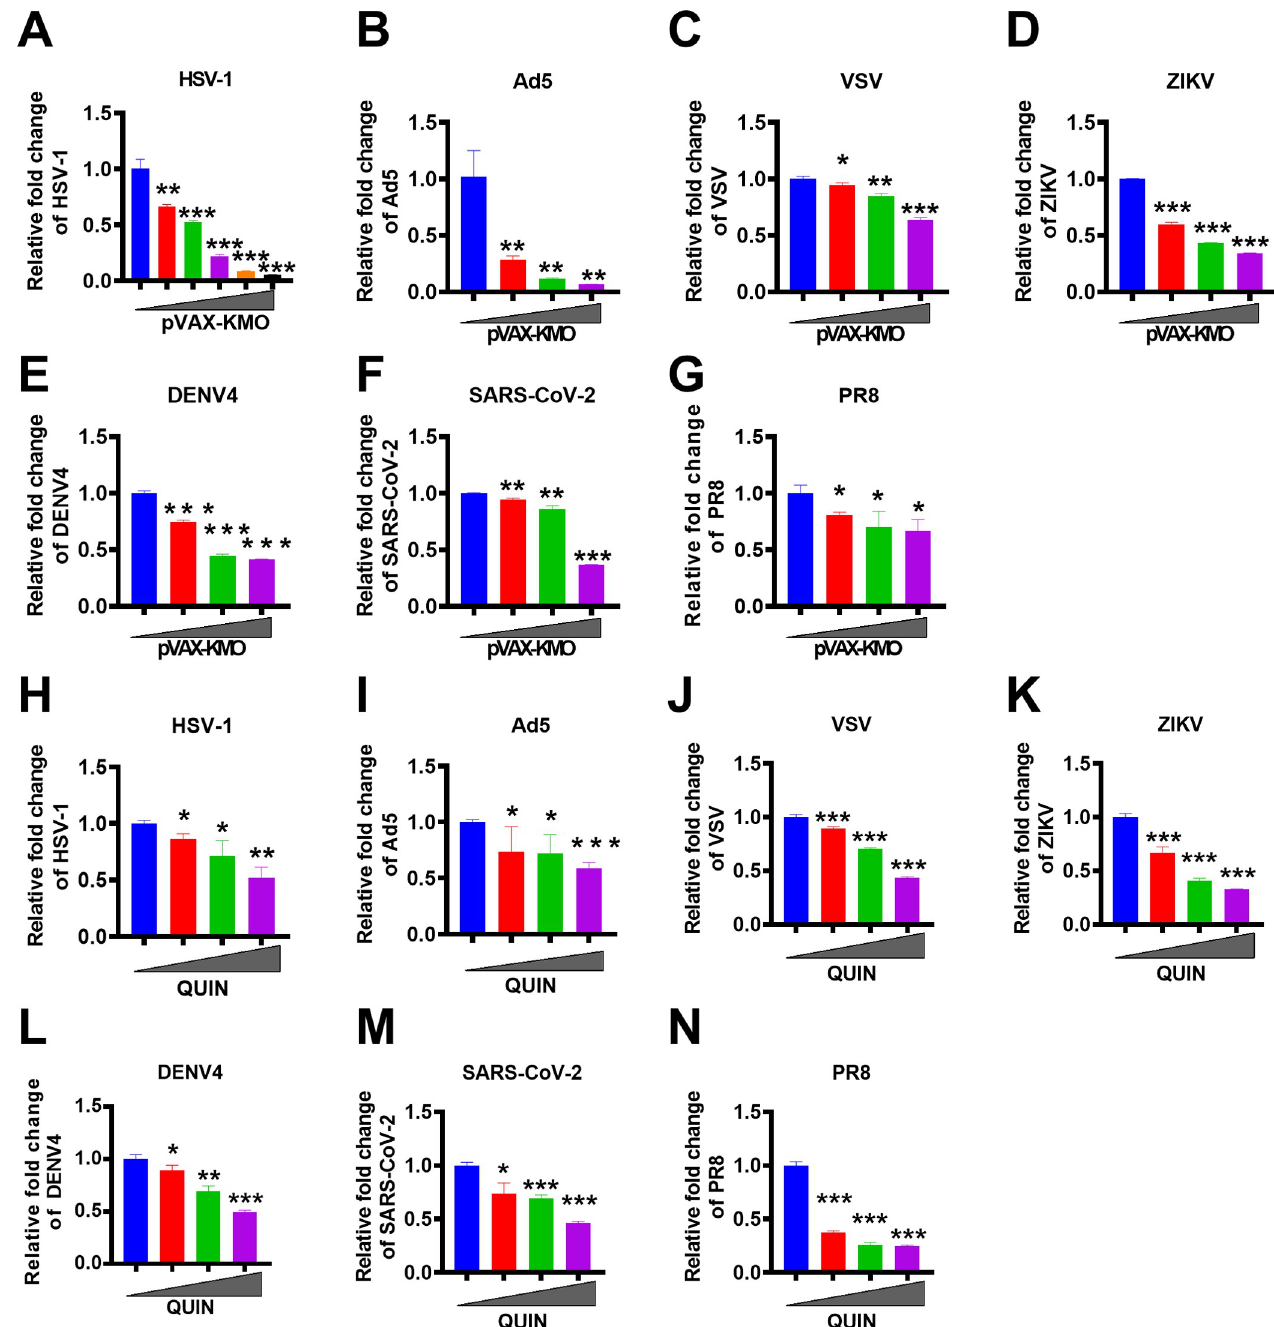
Fig 4. Broadly antiviral activities of KMO and QUIN. (A) 293T cells were transfected with different concentrations of KMO-expressing plasmid for 24 h, followed by HSV-1 infection at MOI of 1 for 8 h. The expression level of HSV-1 UL27 was quantified by RT-qPCR. (B) 293T cells were transfected with different concentrations of KMO-expressing plasmid for 24 h, followed by Ad5 infection at MOI of 1 for 8 h. The expression level of Ad5 was quantified by RT- qPCR. (C) 293T cells were transfected with different concentrations of KMO-expressing plasmid for 24 h, followed by VSV infection at MOI of 1 for 8 h. The expression level of VSV was quantified by RT-qPCR. (D) 293T cells were transfected with different concentrations of KMO-expressing plasmid for 24 h, followed by ZIKV infection at MOI of 1 for 8 h. The expression level of ZIKV was quantified by RT-qPCR. (E) 293T cells were transfected with different concentrations of KMO-expressing plasmid for 24 h, followed by DENV4 infection at MOI of 1 for 8 h. The expression level of DENV4 was quantified by RT- qPCR. (F) CoCa-N-2 cells were transfected with different concentrations of KMO-expressing plasmid for 24 h, followed by replication-competent SARS-CoV- 2 virus-like-particles (SARS-CoV-2 GFP/ Δ N) infection at MOI of 1 for 8 h. The expression level of SARS-CoV-2 GFP/ Δ N was quantified by RT-qPCR. (G) 293T cells were transfected with different concentrations of KMO-expressing plasmid for 24 h, and the expression level of PR8 was quantified by RT- qPCR.